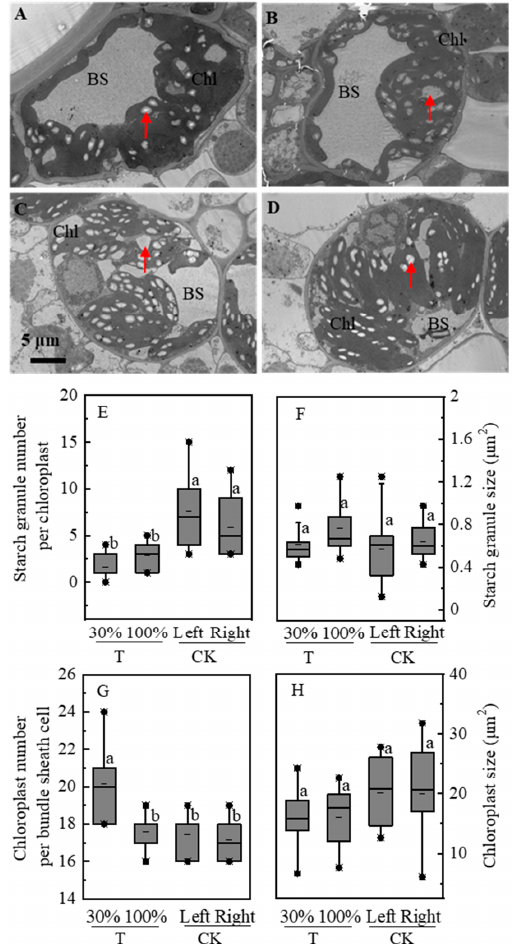
Figure 3. Starch granules, chloroplast number, and size of leaves in shading treatments. The arrow points to starch granules, Chl: chloroplasts, BS: bundle sheath cells. ( A ): starch granules and chloroplasts of T-30%; ( B ): starch granules and chloroplasts of T-100%, the ear leaf in full sunlight; ( C ): starch granules and chloroplasts of CK-left; ( D ): starch granules and chloroplasts of CK-right; ( E ): starch granule number per chloroplast; ( F ): starch granule size; ( G ): chloroplast number per bundle sheath cell; ( H ): chloroplast size. The short solid line within each box represents the median and mean values of all data. Plants grown under heterogeneous light (T), the left side leaves were under shade (T-30%) and right side leaf under natural light (T-100%). All leaves were under full sunlight (CK). Data with different letters are significantly different ( p <